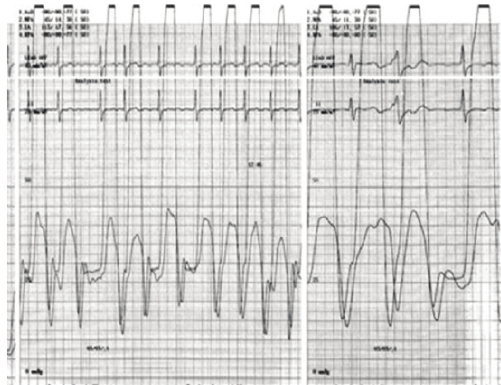
Figure 3: Equalization of right sided and left-sided diastolic filling pressures, with characteristic dip, and plateau in right-left cardiac